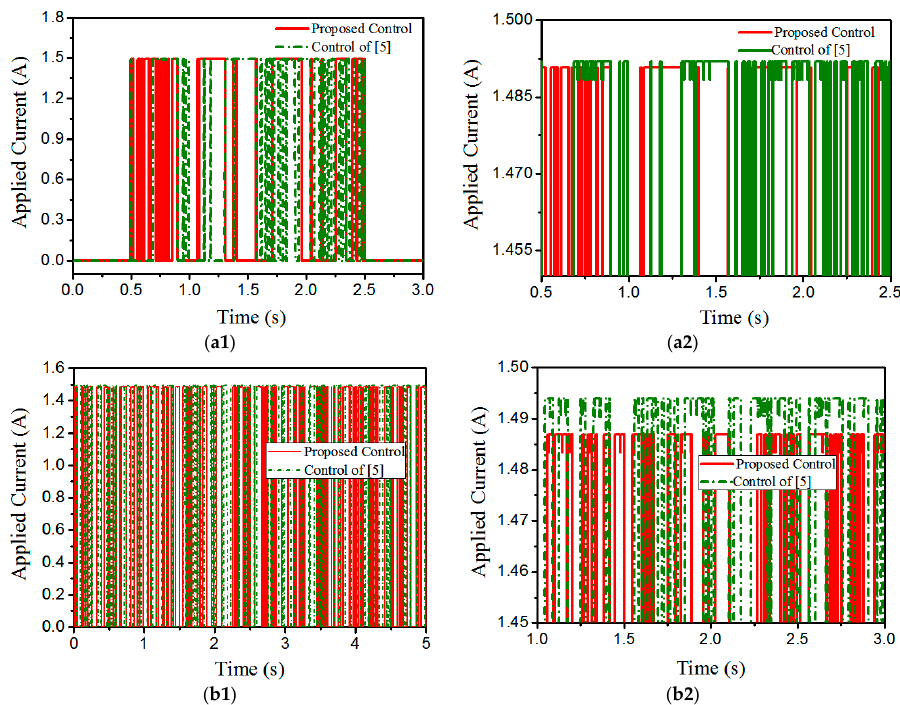
Figure 9. Applied control current: ( a1 , a2 ) regular bump excitation; ( b1 , b2 ) random-step-wave excitation.